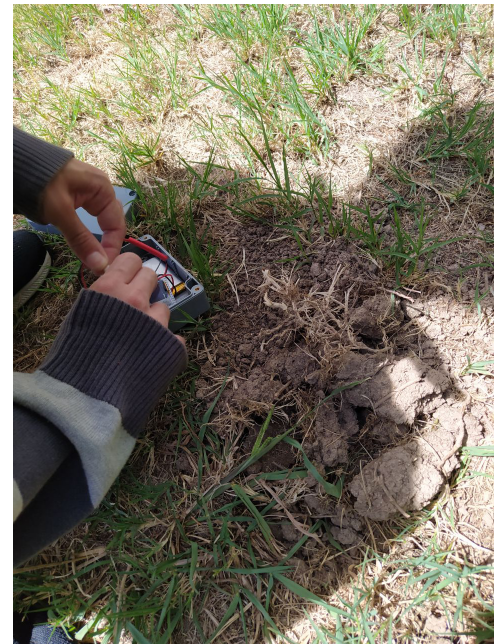
Figure 17. Deployment of one of the smart irrigation nodes.